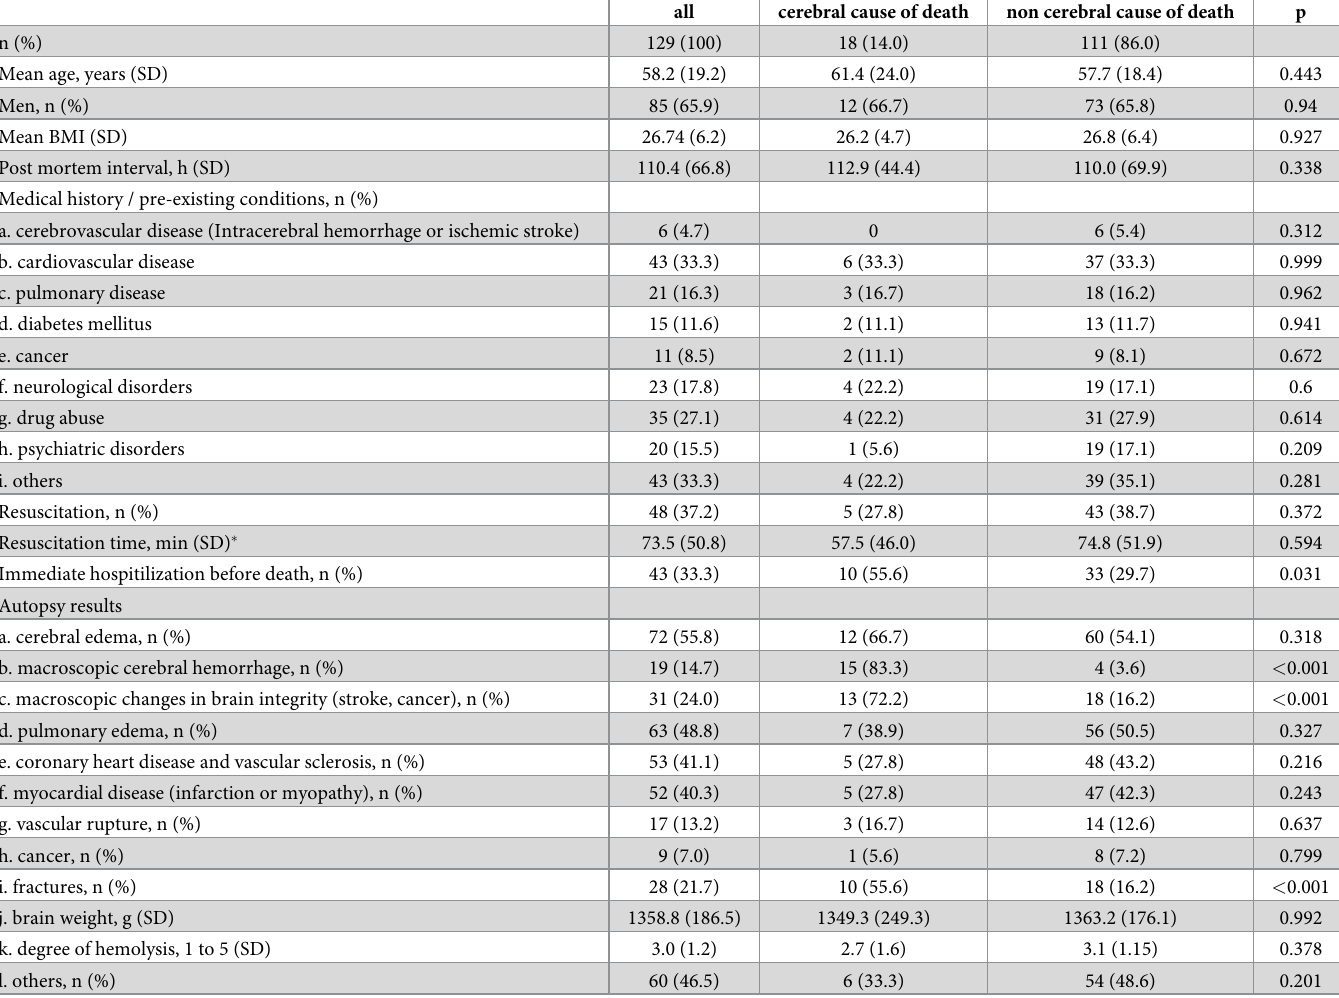
Table 1. Characteristics of the study